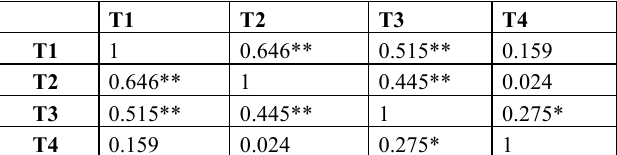
Table 7. Correlation analysis for the basic syllabus (* p<0.05, **